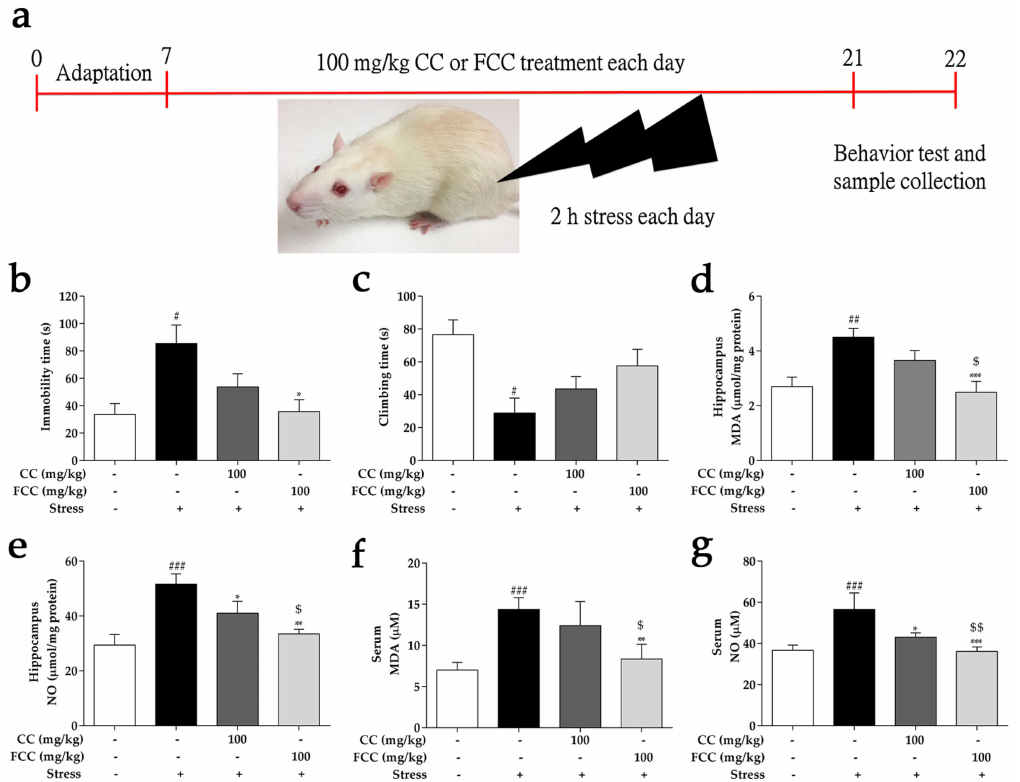
Figure 2. Pretreatment with CC or FCC relieved depression-like behavior and weakened oxidative stress in stress-induced rats. ( a ) Experimental design of rat immobilization stress. The ( b ) immobility time and ( c ) climbing time was measured in the forced swim test (FST). The oxidative stress markers ( d , f ) malondialdehyde (MDA) and ( e , g ) nitric oxide (NO) were estimated in rat hippocampus and serum by Thiobarbituric acid reactive substances (TBARS) and Griess reagent kits. “ + , -”: Rats were treated with or without CC extract, FCC extract or stress. The data are expressed as mean ± SD, n = 8. # p < 0.05, ## p < 0.01, ### p < 0.001 compared to the control group, * p < 0.05, ** p < 0.01, *** p <